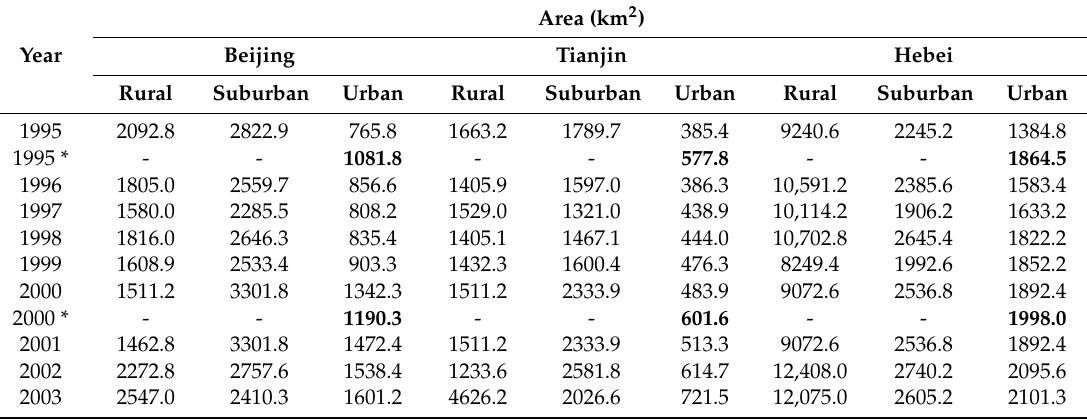
Table A1. Di ff erent land use area for each